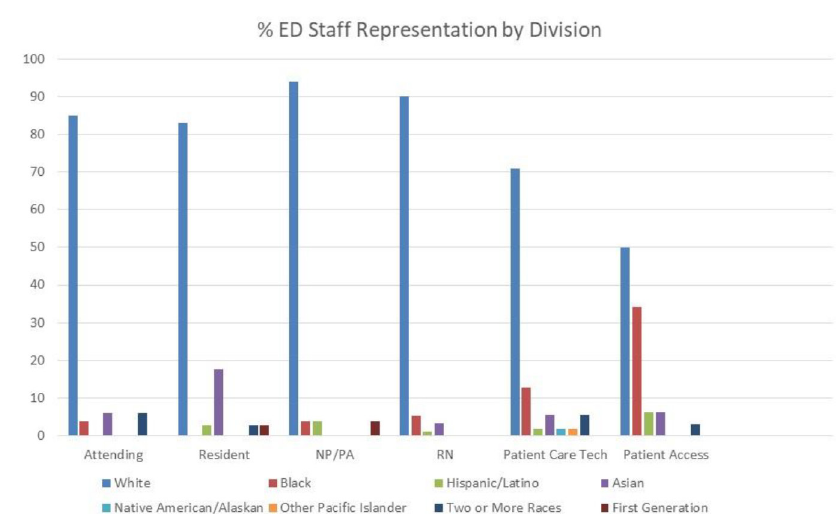
Figure 2. Ethnic/racial make-up of emergency department staff by division at Albany Medical Center. ED , emergency department; NP , nurse practitioner; PA , physician assistant; RN , registered